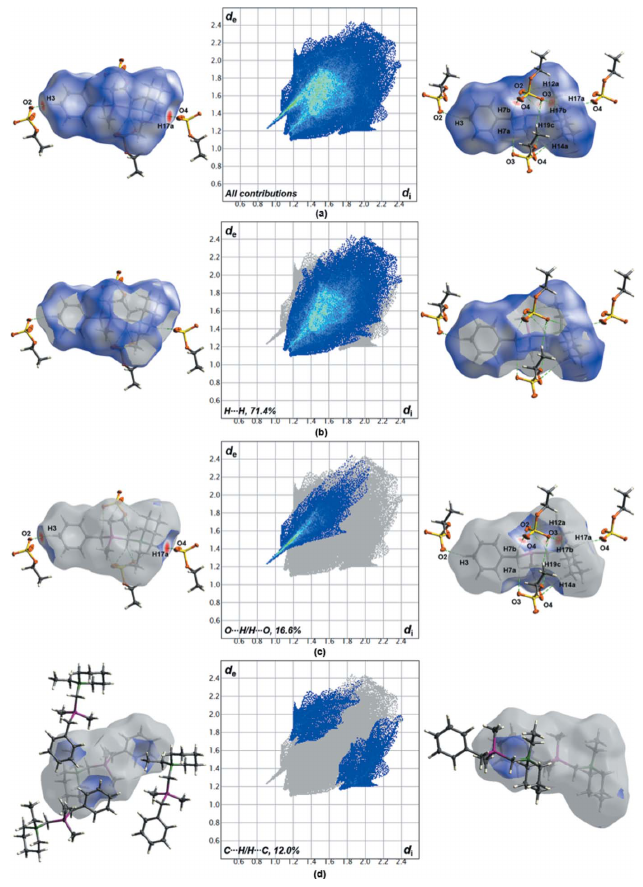
Figure 4 Hirshfeld surfaces and two-dimensional fingerprint plots of 1 showing close contacts for ( a ) all contributions in the crystal and ( b ) H (cid:2)(cid:2)(cid:2) H, ( c ) O (cid:2)(cid:2)(cid:2) H/H (cid:2)(cid:2)(cid:2) O and ( d ) C (cid:2)(cid:2)(cid:2) H/H (cid:2)(cid:2)(cid:2) C interactions. Symmetry code: (cid:3) x , 1 + y , (cid:3) z . 2